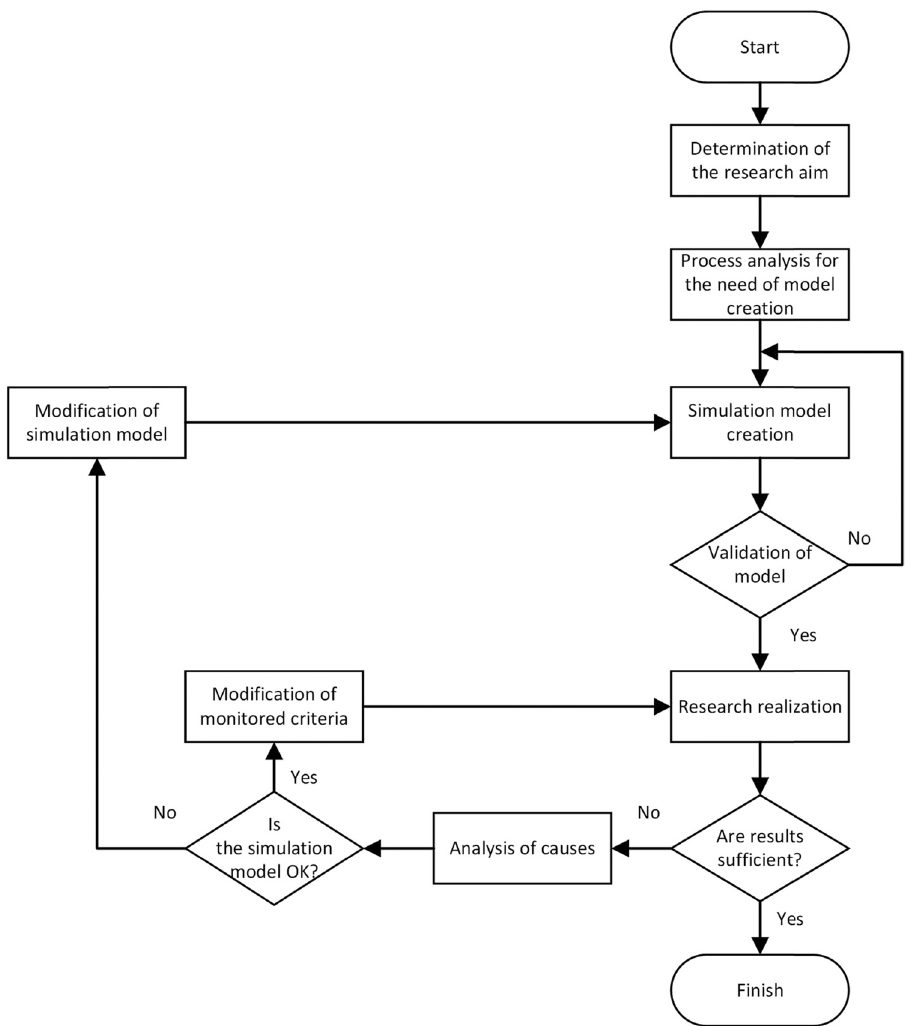
Figure 2: Block diagram of the research